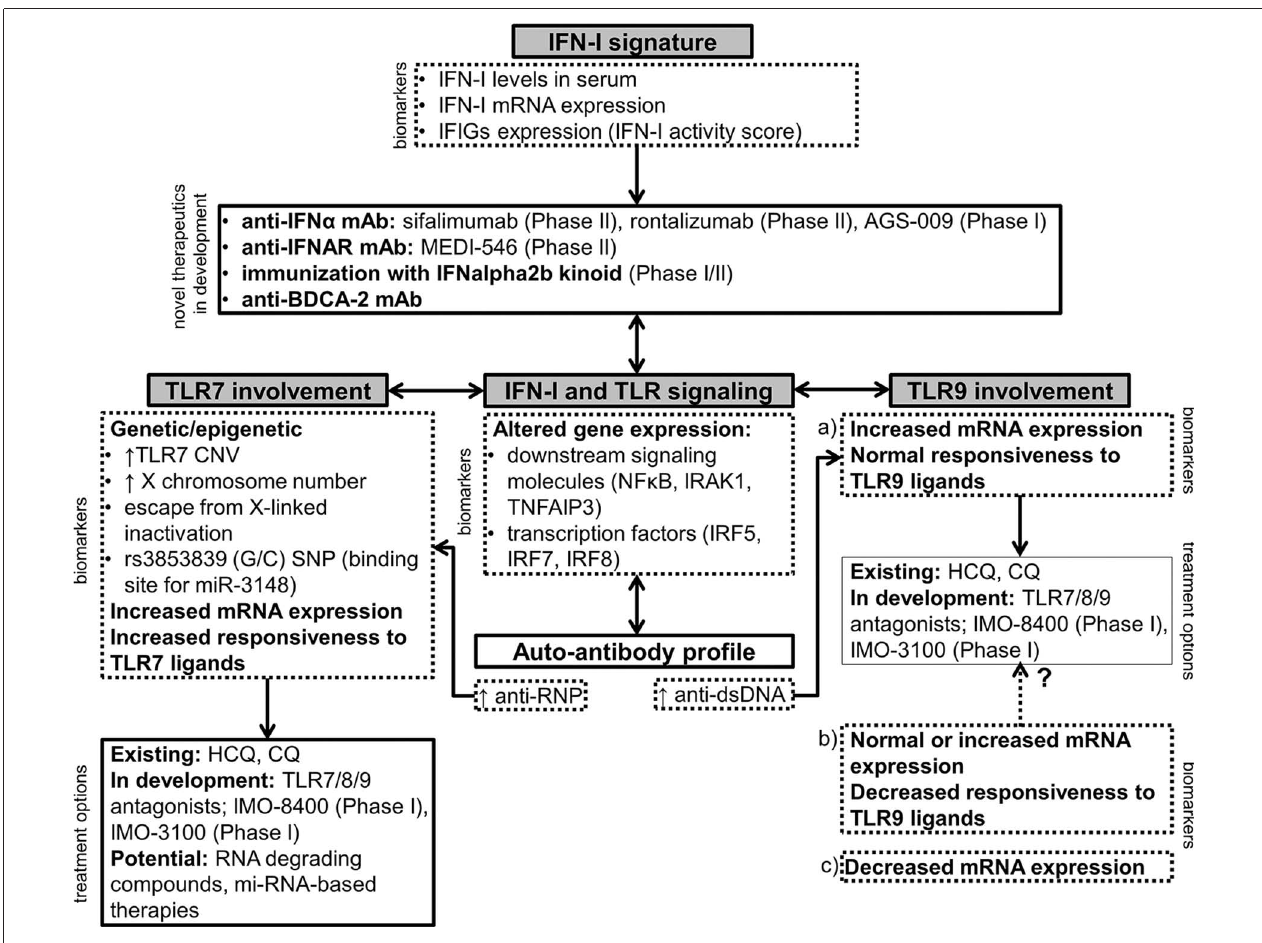
patient. Drugs that are currently in clinical development are listed with the corresponding phase of the clinical trial (Clinicaltrials.gov, 2014). IFIGs, interferon-inducible genes; HCQ, hydroxychloroquine; CQ,